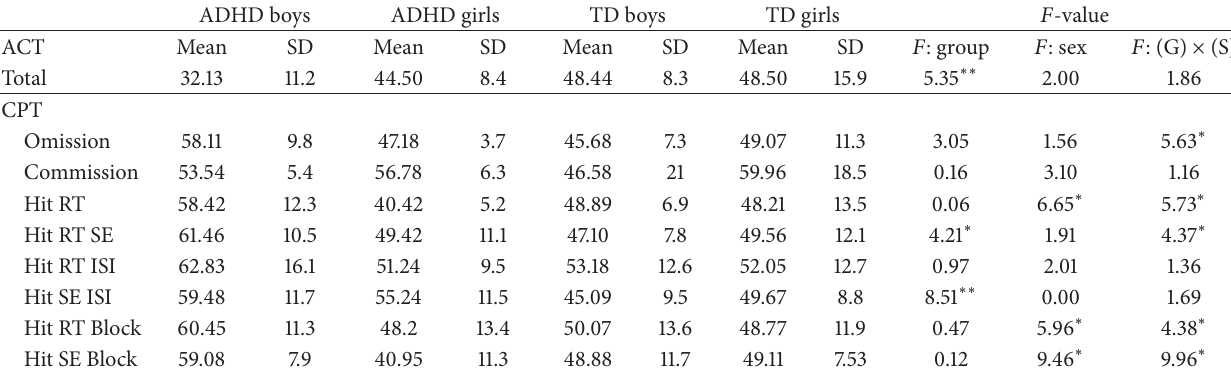
Table 2: Neuropsychological profile of participants with ADHD and typically developing youth (TD). ADHD boys ADHD girls TD boys TD girls 𝐹 -value